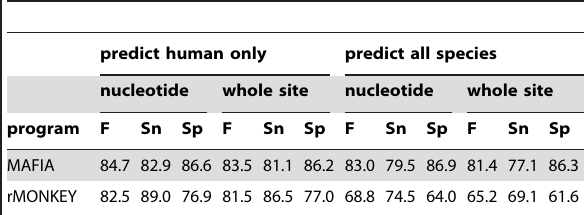
Table 2. Binding-site prediction accuracy for PSPE simulation runs.